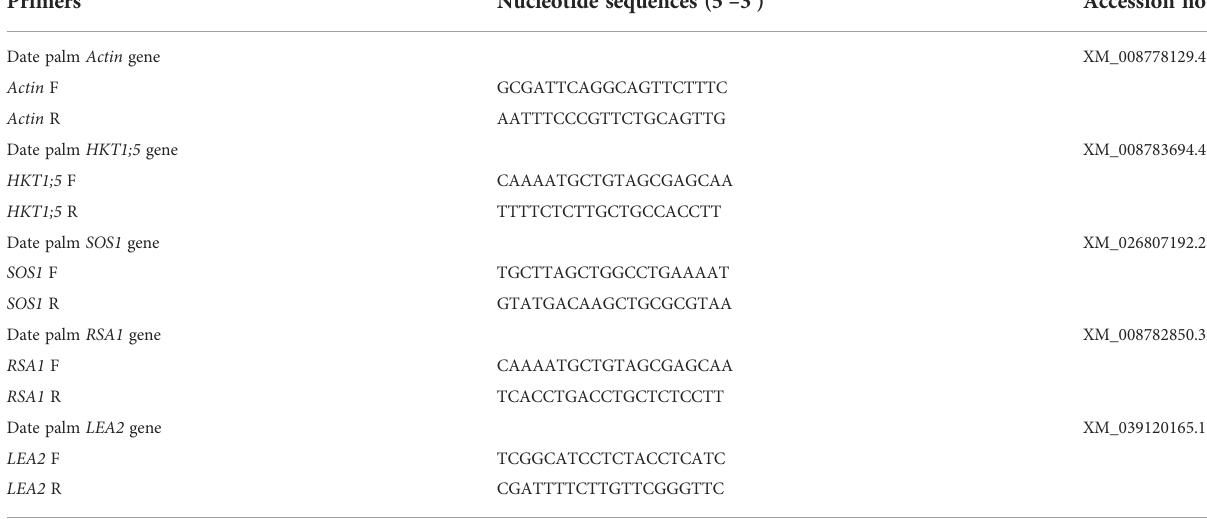
TABLE 1 Sequences of oligonucleotides used in real-time PCR expression analysis.